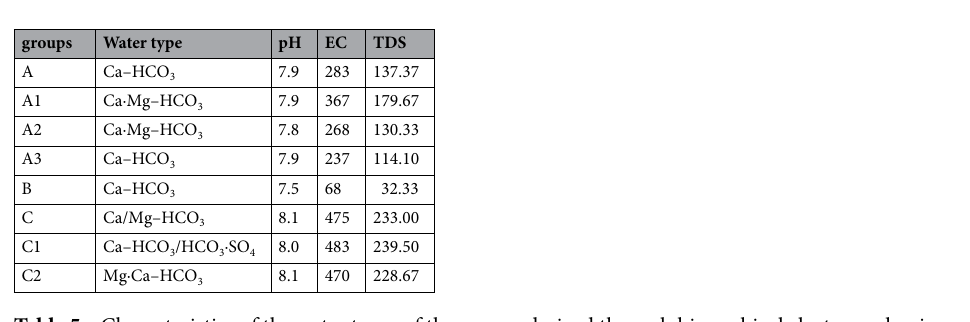
Table 5. Characteristics of the water types of the groups derived through hierarchical cluster